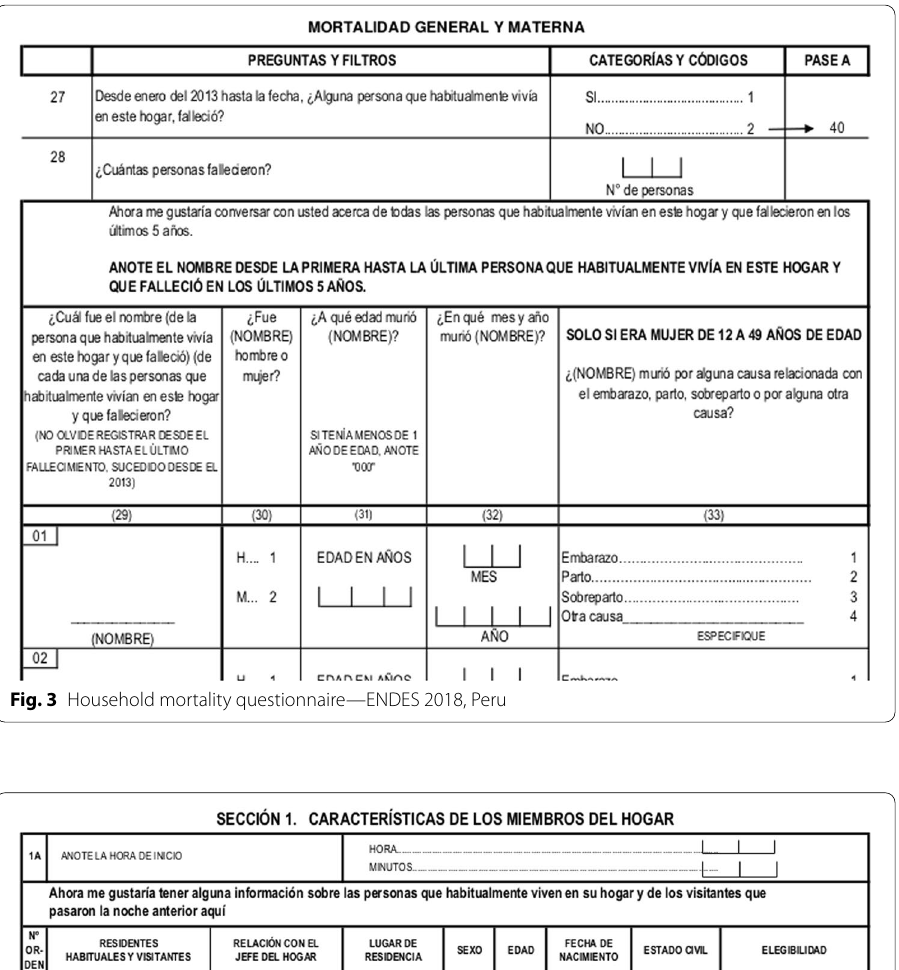
Fig. 3 Household mortality questionnaire—ENDES 2018, Peru